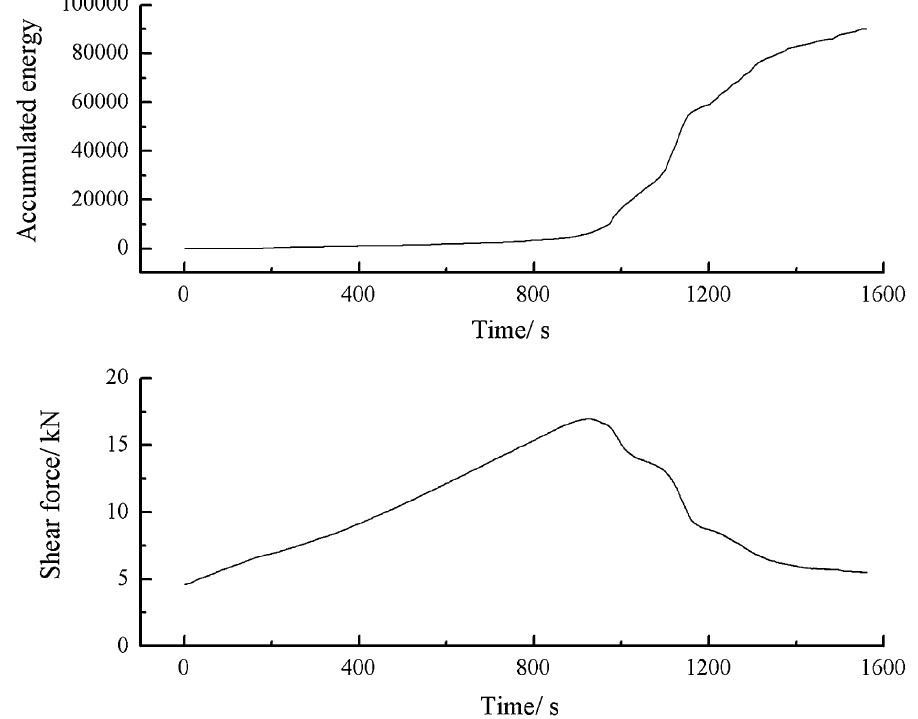
Figure 56. Shear stress–time and acumulative energy-time curves for a specimen containing 0–0.6 mm and 1–2.56 mm sand particles (two grain size ranges).